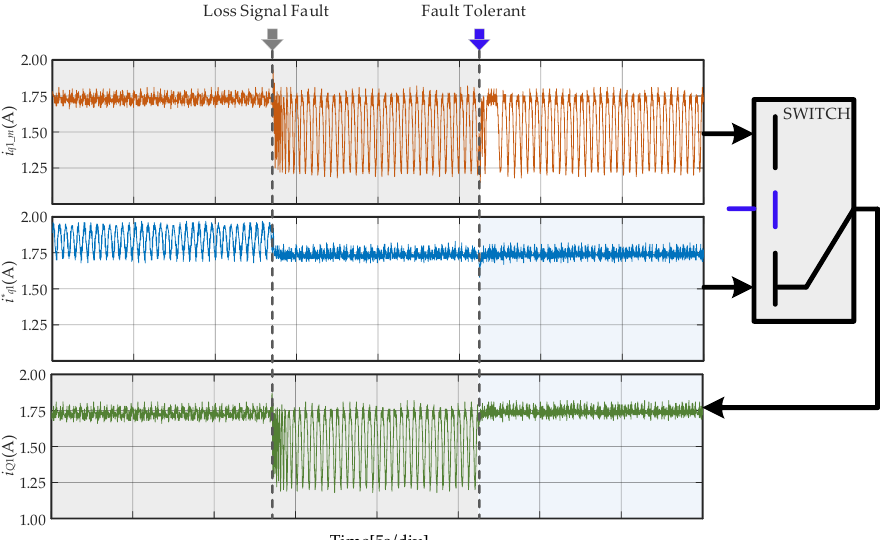
* q 1_m , i q 1 and i Q 1 in different